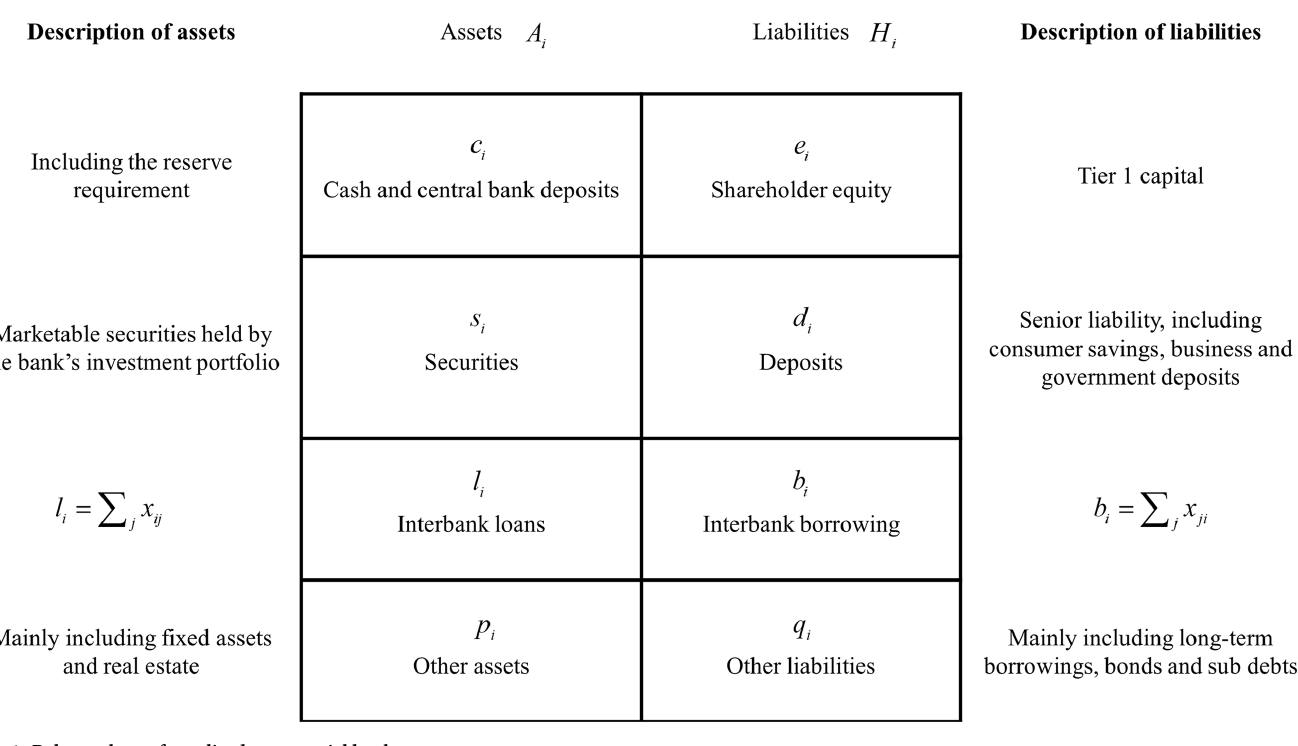
Fig 1. Balance sheet of a stylized commercial